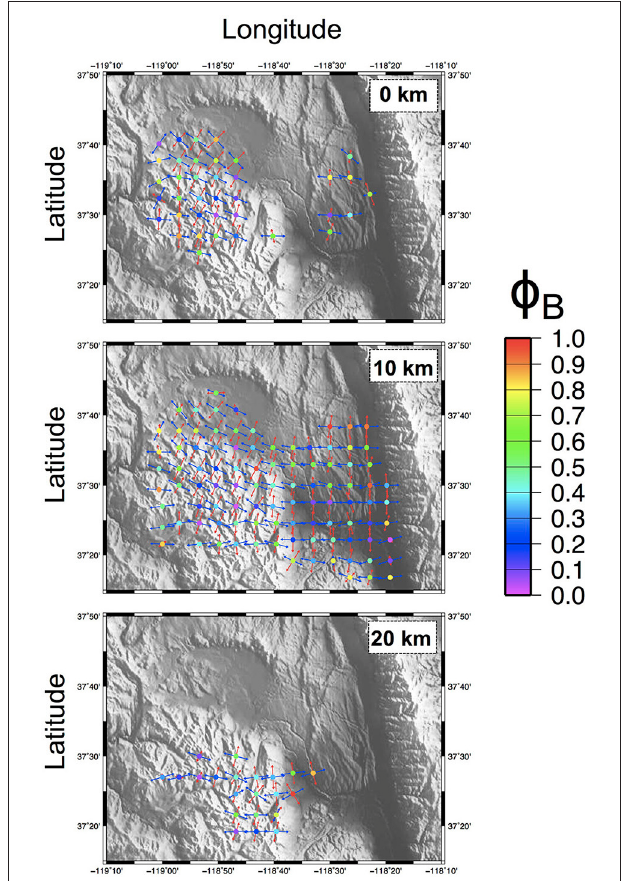
FIGURE 10 | Long Valley. Stress field tensors retrieved from focal mechanisms data using the BRTM. Slices at 0, 10, and 20 km-depth. Stress tensors have been computed over a regular grid of 5-km spacing, considering only nodes containing at least 10 FPSs. σ 1 and σ 3 axes are plotted as pairs of respectively red-blue arrows. The color of the circles corresponds to the retrieved 8 B value for each node (see scale on the